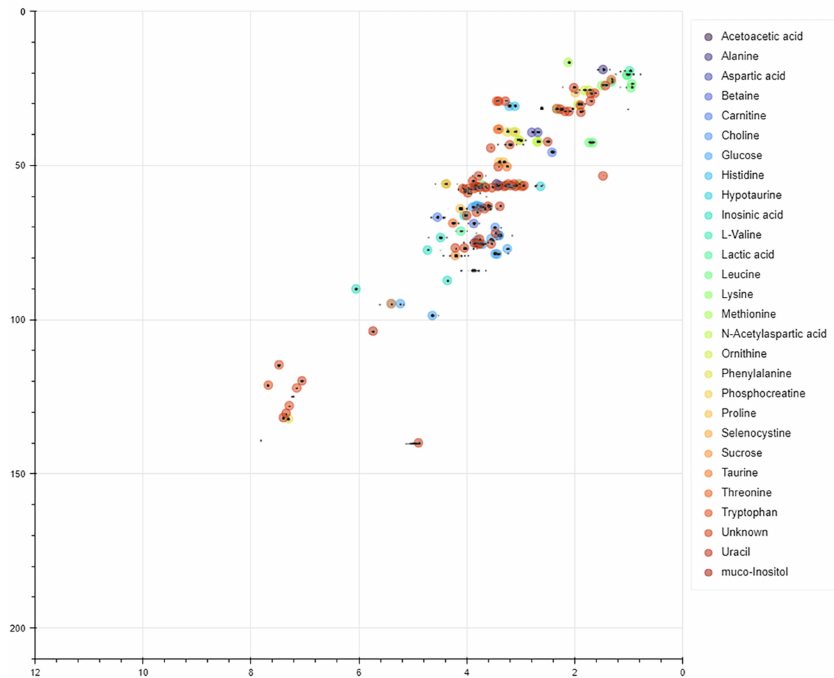
Figure 24. Overlay of experimental HSQC spectra from a metabolite mixture (black correlations) and the outcomes predicted by SMART-Miner (colored correlations). Figure reprinted with permission from Ref. [126]. Copyright 2021 Wiley Periodicals,